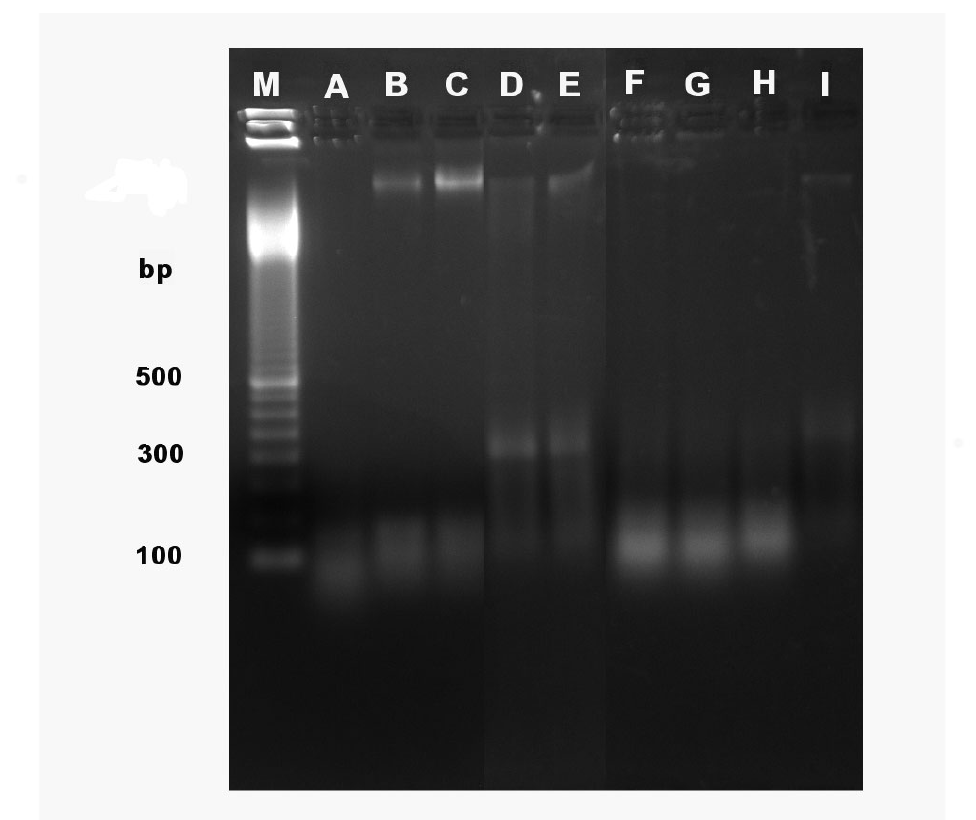
Figure 4: Electrophoretic analysis of genomic DNA of CHO-K1 cells after C. d. terrificus crude venom treatment. Cells were incubated for 1, 6 and 12h with 10, 50 and 100 μ g/ml venom. Genomic DNA was extracted and analyzed by electrophoresis on a 1.5% agarose gel containing ethidium bromide. CHO-K1 cells treated with C. d. terrificus crude venom exhibited the ladder pattern characteristic of apoptosis. M, Marker; A, 10 μ g/ml; B, 50 μ g/ml; C, 100 μ g/ml – after 1 h; D, 10 μ g/ml; E, 50 μ g/ml; F, 100 μ g/ml – after 6 h; G, 10 μ g/ml; H, 50 μ g/ml; I, 100 μ g/ml – after 12